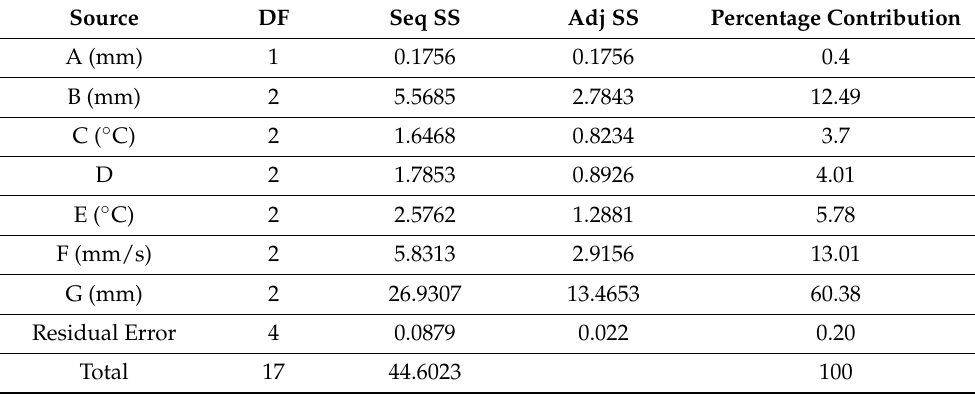
Table 7. ANOVA Table for the Ra-ABS polymer.